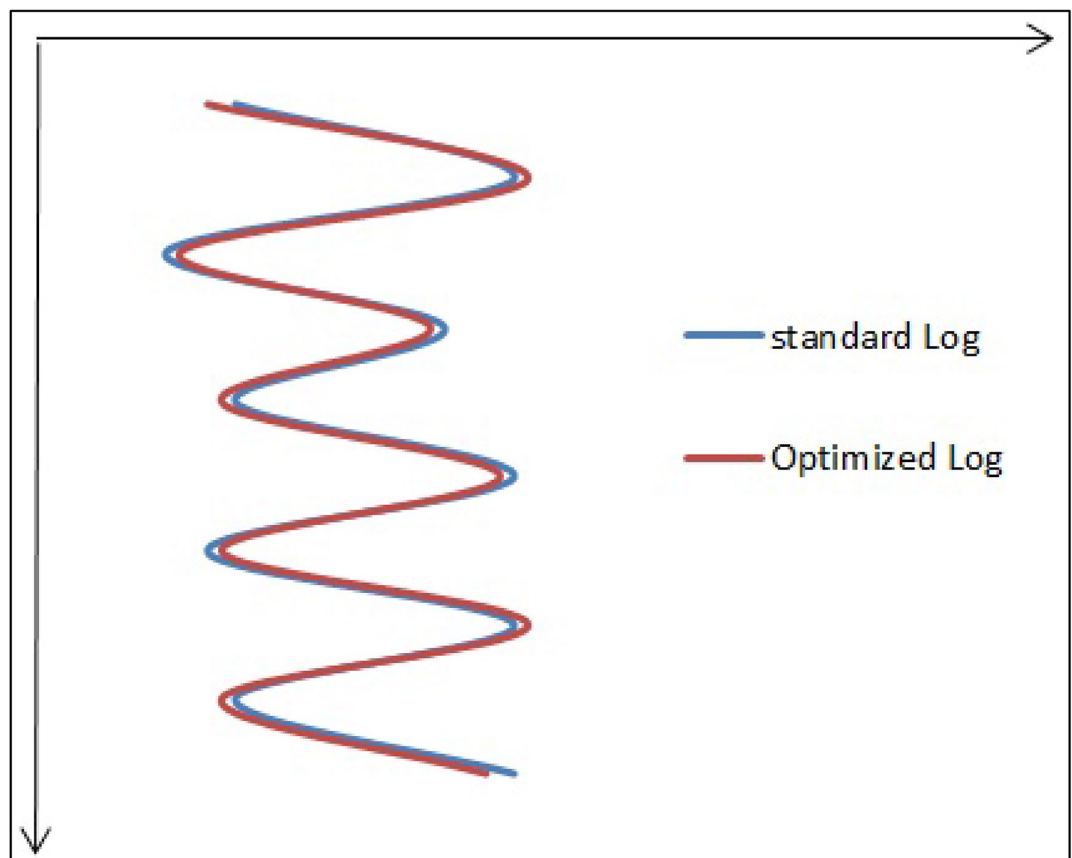
Fig. 9 Matching the constructed log with the standard